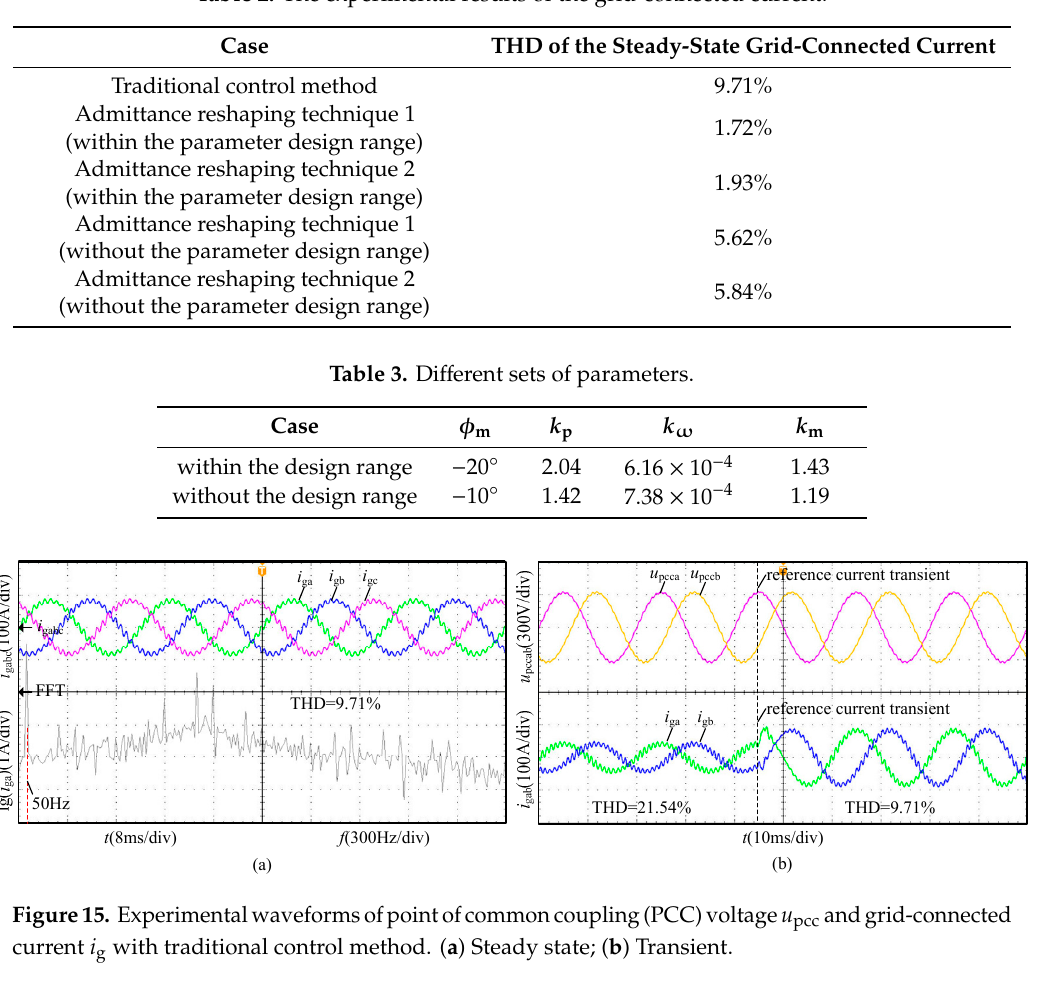
Figure 17. Experimental waveforms of u pcc and i g with proposed admittance reshaping technique 2 within the parameter design range. ( a ) Steady state; ( b ) Transient. To verify the reasonableness of the parameter design for the proposed admittance reshaping techniques 1 and 2, another set of parameters without the design range is shown in Table 3. The experimental waveforms of PCC voltage u pcc and grid-connected current i g in both cases are shown as Figures 18 and 19. The experimental results of the grid-connected current in both cases are shown in Table 2.